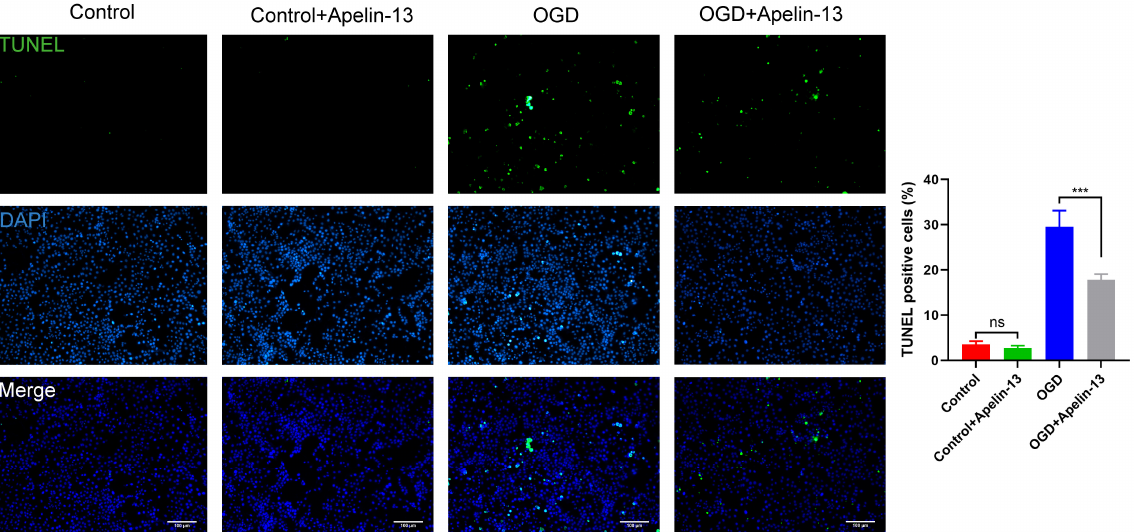
Figure 8. The TUNEL assay results showed that compared with the OGD group, apoptosis in the OGD+Apelin-13 group was significantly reduced. Scale bar = 100 μ m. *** p < 0.001. ns, not significant.